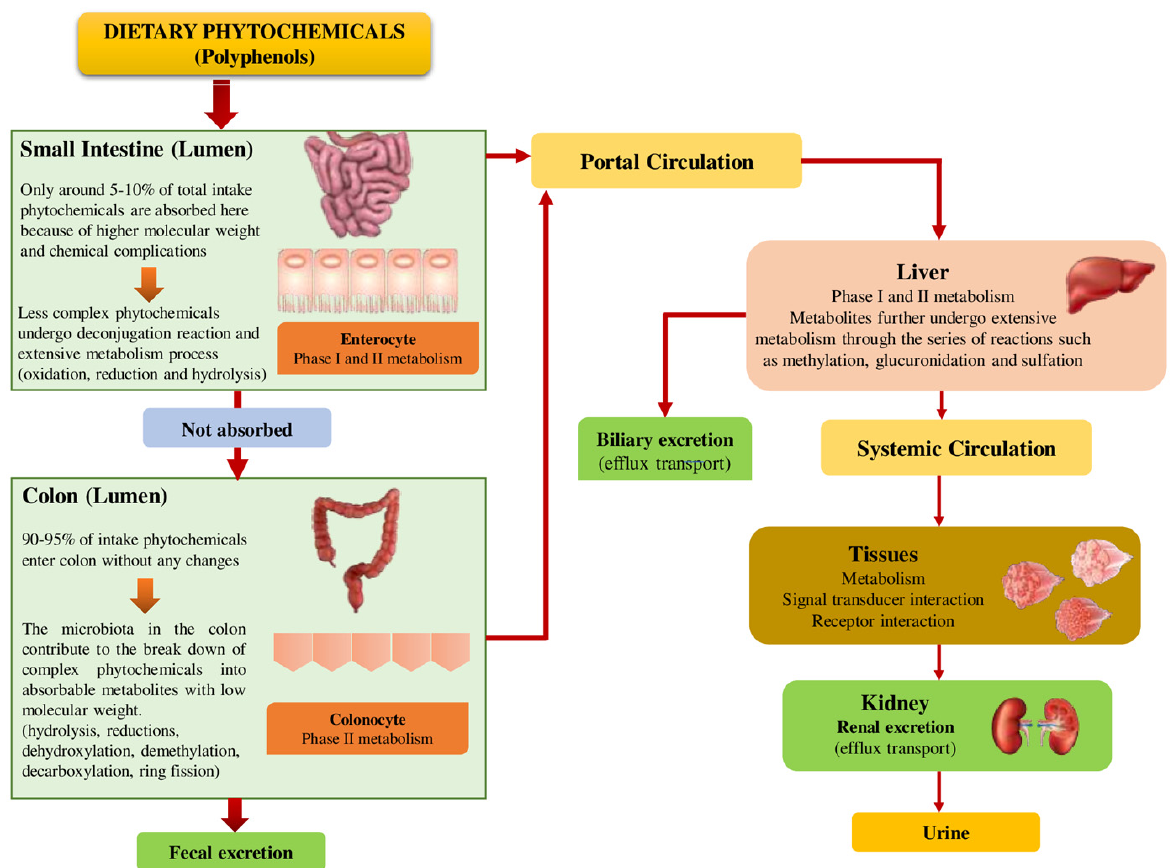
Figure 3. Simple illustration of the metabolic pathway of dietary phytochemicals in human body